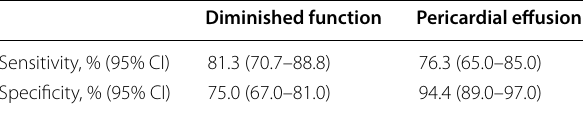
Table 5 Performance metrics of overall